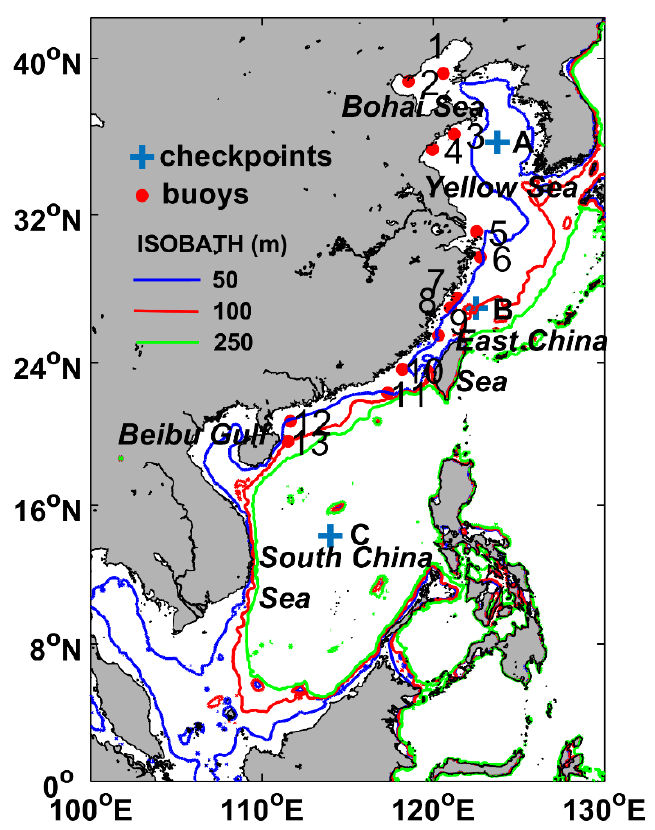
Figure 1. Geographical distribution of water depth (m) in China Seas. The red dots marked 1 to 13 indicate the locations of the offshore wind buoys. The crosses marked A, B, and C denote the locations of three randomly selected grid points for consistency analysis of ASCAT and QuikSCAT wind products.